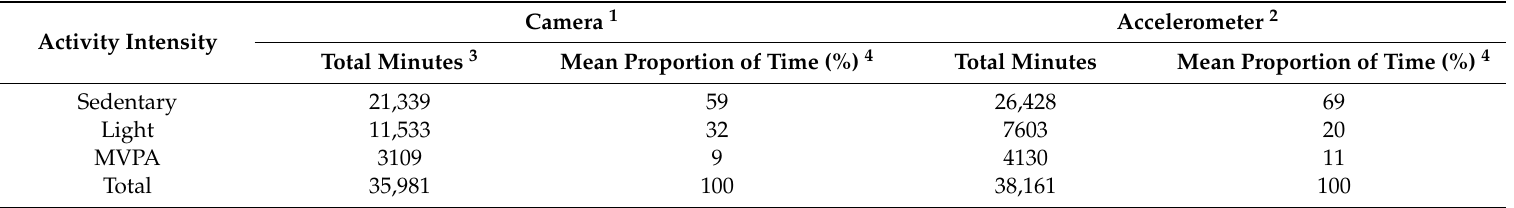
Table 3. Minutes of sedentary, light and moderate-to-vigorous physical activity for the camera and accelerometer with the proportion of time spent in each activity intensity, n = 636 person-hours; n = 53